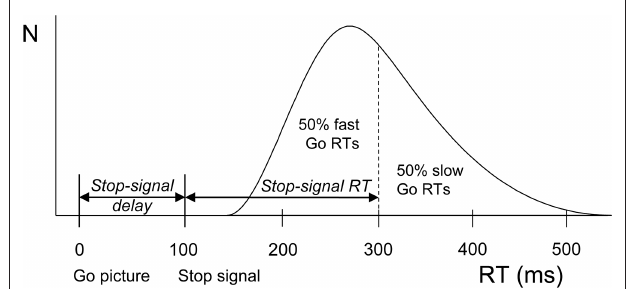
Figure 1 | Calculation of SSrT according to a race model (Logan, 1994; Logan and Cowan, 1984). The curve depicts the distribution of RTs on go trials (trials without a stop-signal) representing the finishing times of the response processes. Assuming independence of go and stop processes, the finishing time of the stop process bisects the Go RT distribution. Given that the response could be withheld on n % of all stop trials (here at 50%), SSRT (200 ms) is calculated by subtracting mean stop-signal delay (100 ms) from the Go RT marking the n -th percentile (300